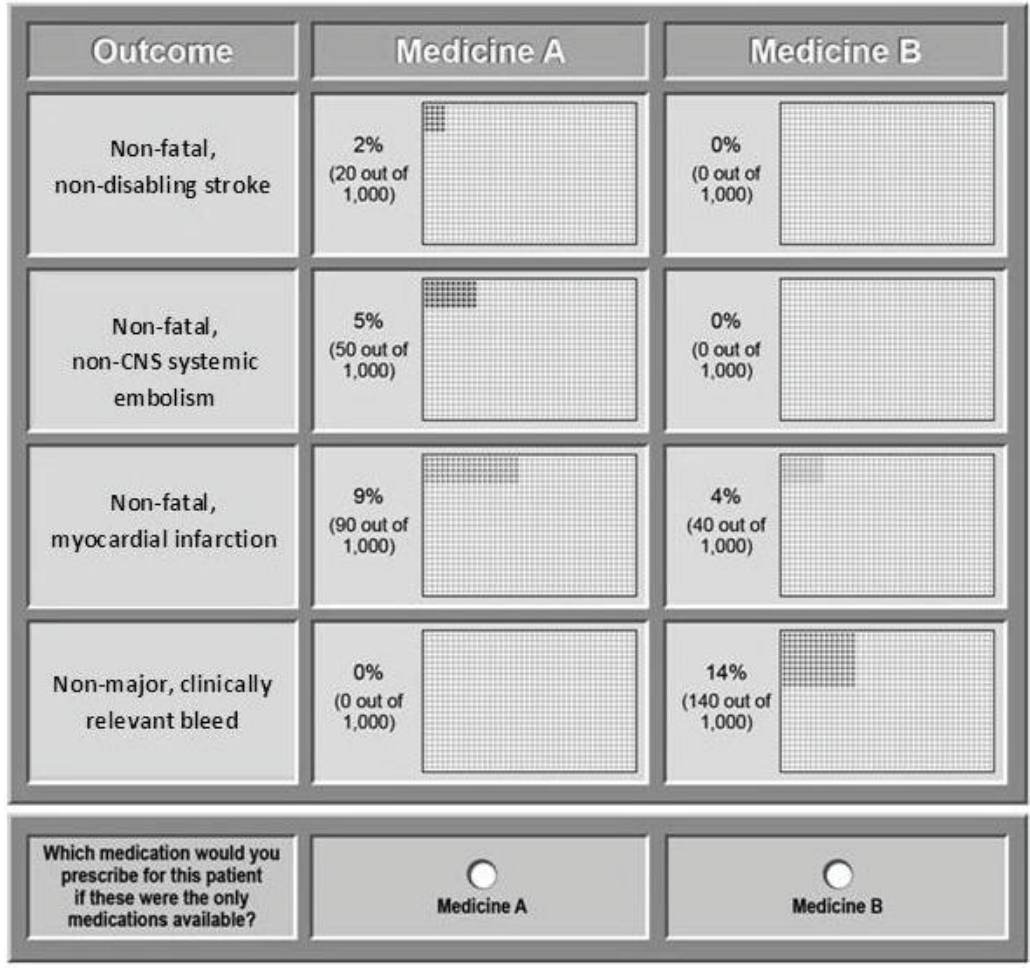
Figure 1. Example of a Choice Question in the Physician